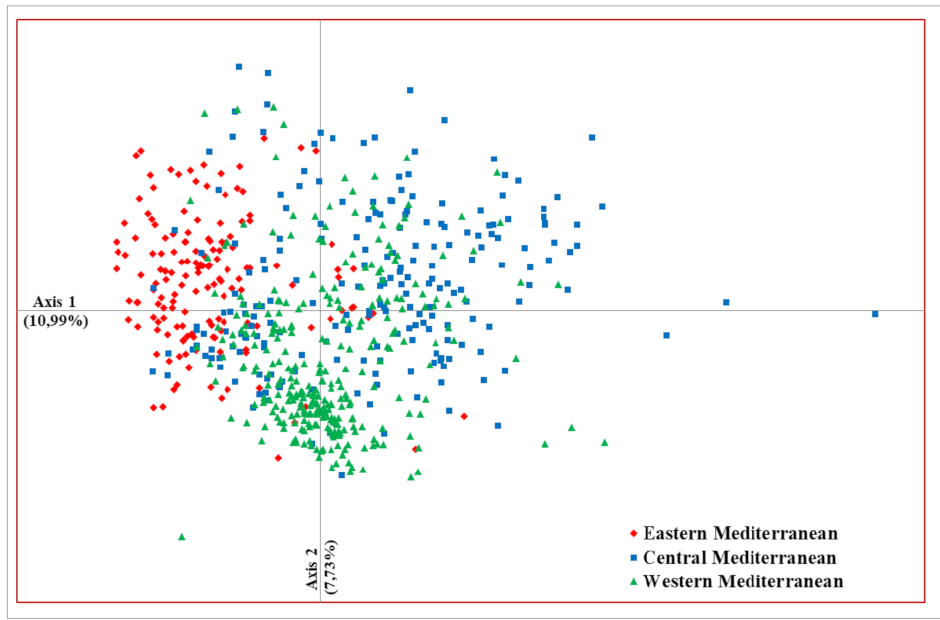
Figure 2. Principal co-ordinate analysis of 668 olive accessions based on 96 EST-SNP markers. Each ac- cession is coloured according to their region of origin: eastern Mediterranean, central Mediterranean, and western